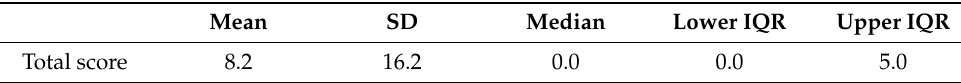
Table 6. Overall OPTION 5